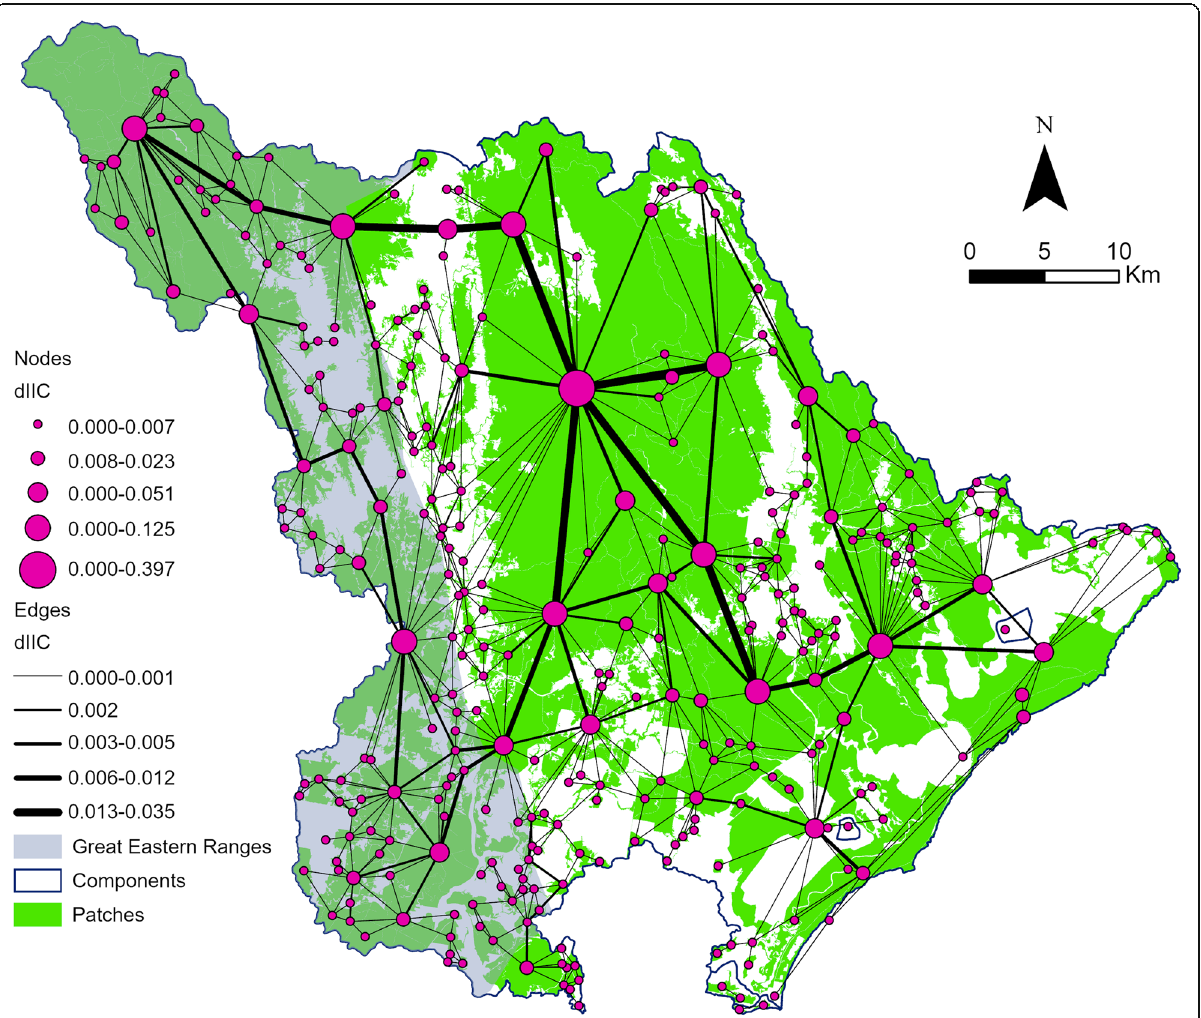
Fig. 8 Habitat patches and the Great Eastern Ranges (GER) with component boundaries and delta integral index of connectivity for patches and linkages. Important linkages and patches are denoted by thick lines and circles respectively. The circles located at the centroid of each patch describe patch-scale graph metric